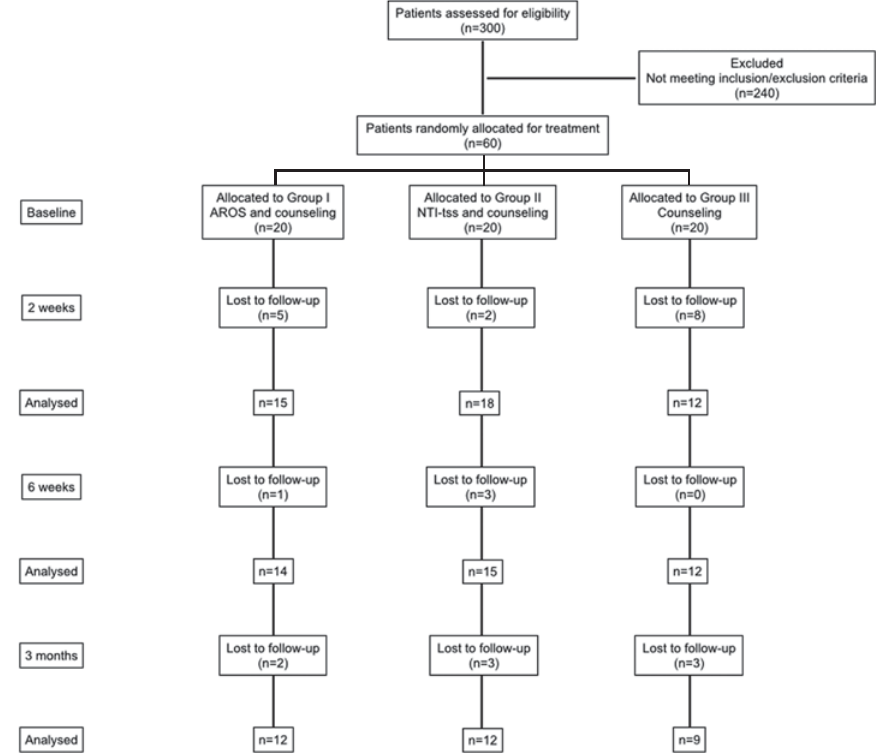
Figure 1- Three hundred patients were clinically examined according to the inclusion and exclusion criteria. Screening showed that 240 subjects met one or more of the exclusion criteria. The remaining 60 patients were randomized for treatment in the study. AROS = anterior repositioning occlusal splint; NTI-tss = Nociceptive Trigeminal Inhibition Clenching